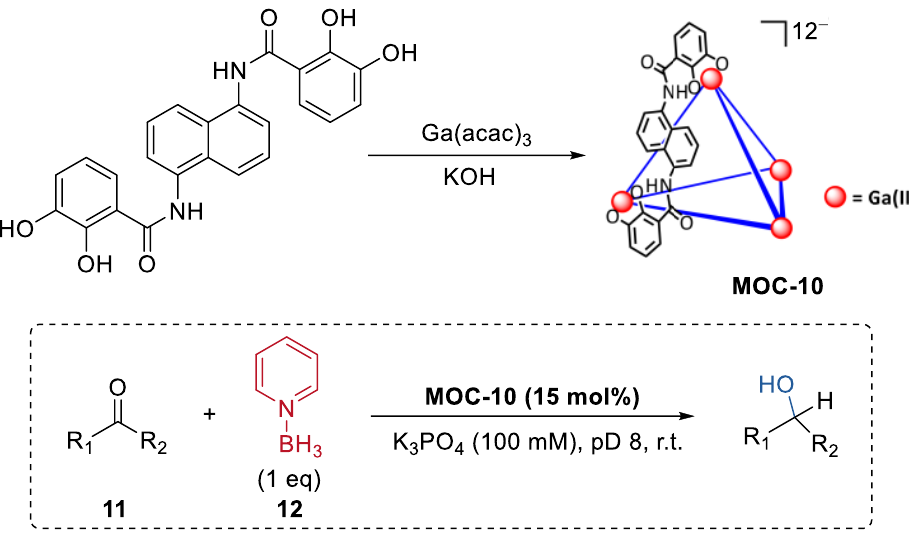
Figure 9. Selective reduction of ketones catalyzed by pyridine-borane encapsulated within MOC-10